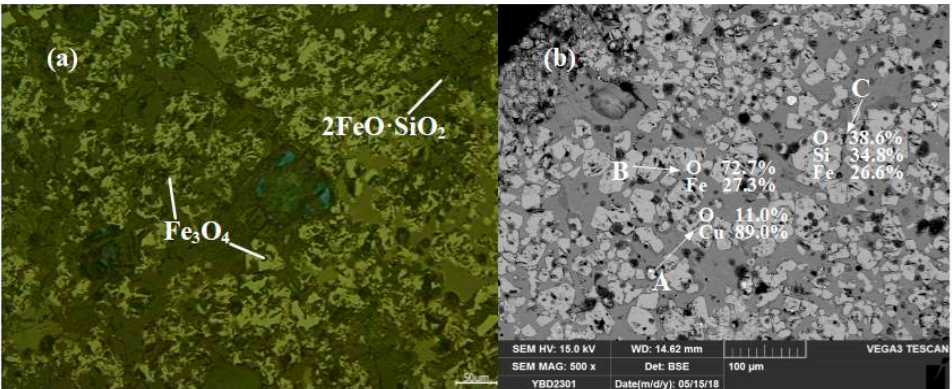
Figure 17. Optical micrograph ( a ) and SEM backsca tt ered electron image ( b ) of YBD21.